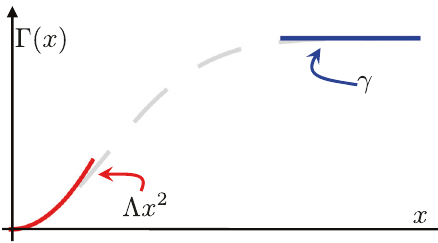
Fig. 1 Decoherence function vs. delocalization distance. Typical dependence of the decoherence function Γ ( x ) from the delocalization distance x . The relevant limits are Γ ( x ) ~ Λ x 2 for x ≪ a and Γ ( x ) ~ γ for x ≫ a , where a is the characteristic length of the noise 36 .